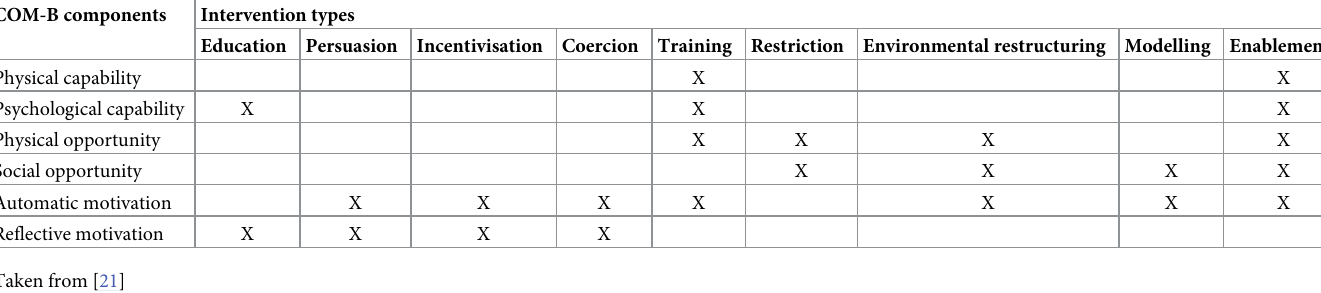
Table 2. Matrix of links between COM-B and intervention